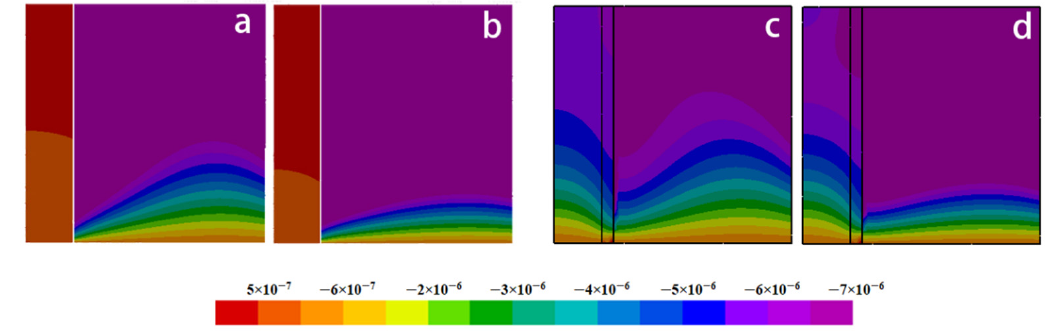
Figure 11. Distributions of axial deformation: ( a ) Fo = 0.156, without coating; ( b ) Fo = 0.234, without coating; ( c ) Fo = 0.156, with coating; ( d ) Fo = 0.234, with coating.